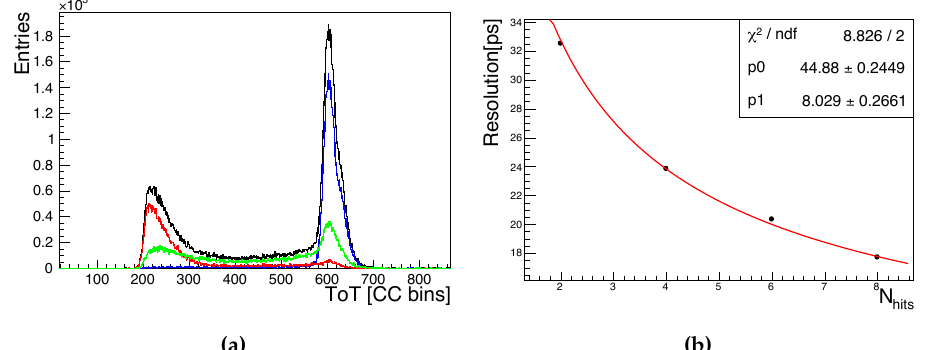
Figure 11.16: Cluster size impact on time resolution: (a) Simulated phase I cluster size per track. (b) Measured time resolution as a function of number of hits using even-odd analysis.